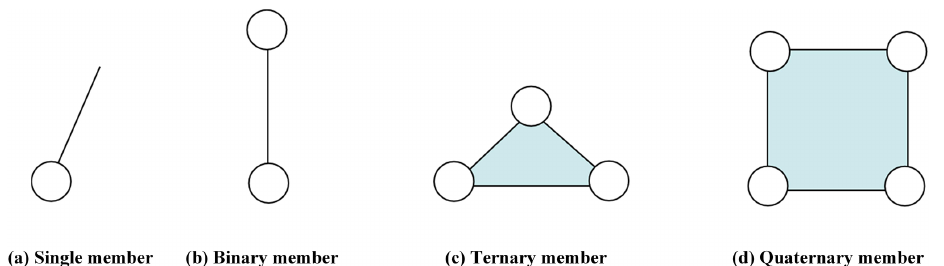
Figure 1. Cotton gin and hand spinning wheel.